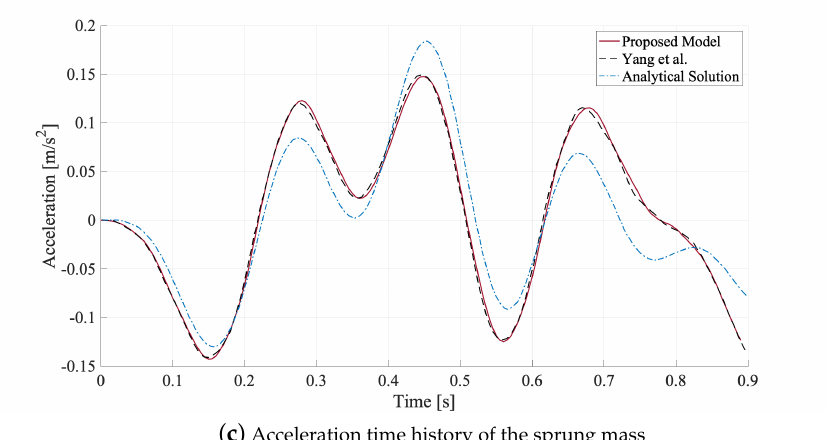
Figure 2. Comparison of the acceleration and displacement response obtained from the developed software with the